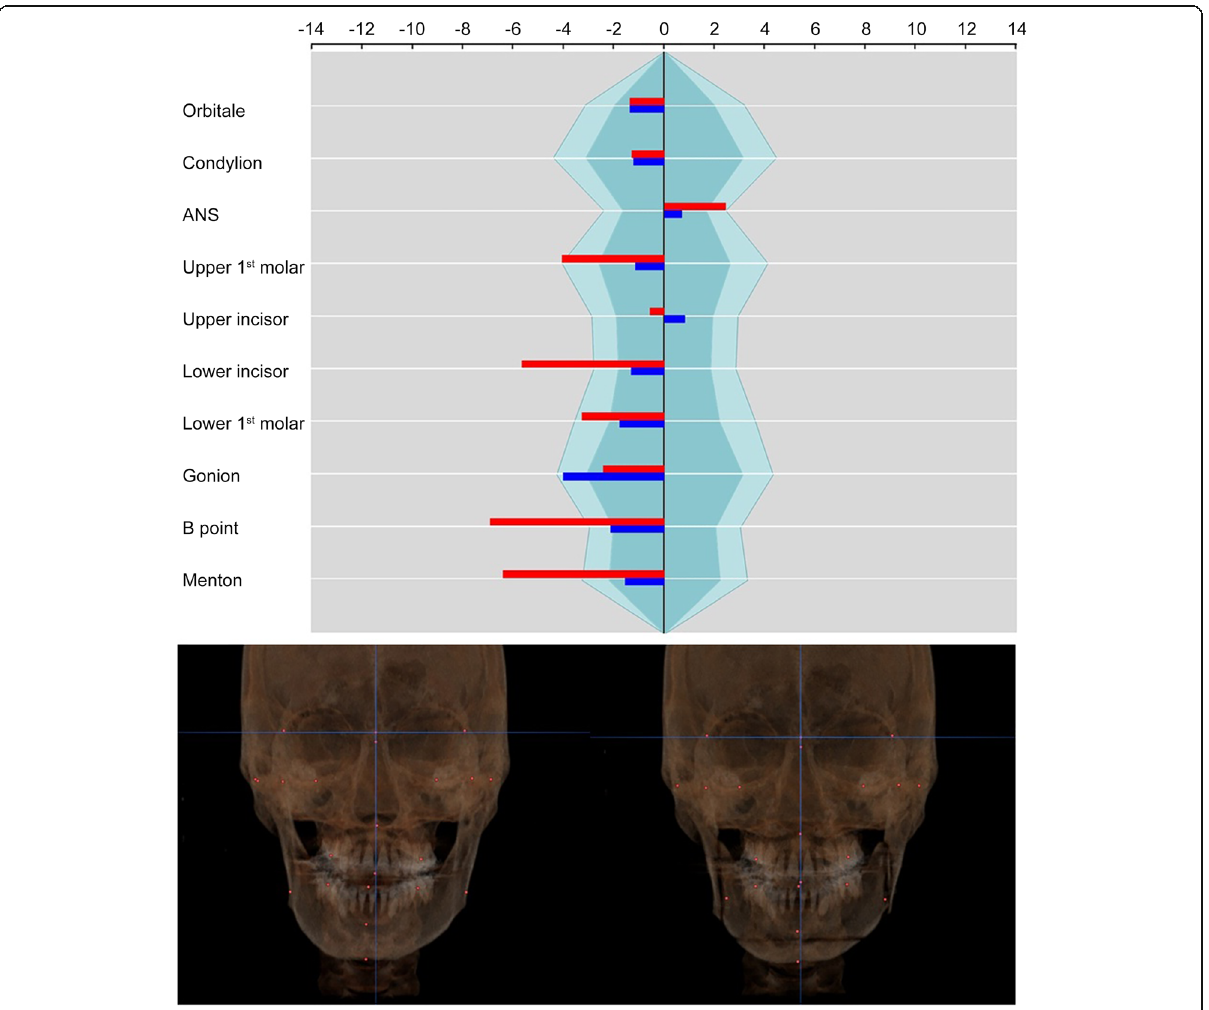
Fig. 7 Case 2. The asymmetry index on U6 and U1 was improved by canting correction and midline correction of the maxilla. Mandibular asymmetry was improved by asymmetric setback surgery (red: before surgery, blue: after